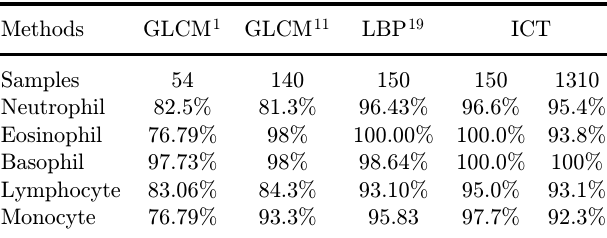
Table 7. The counts of sample images and accuracy rate